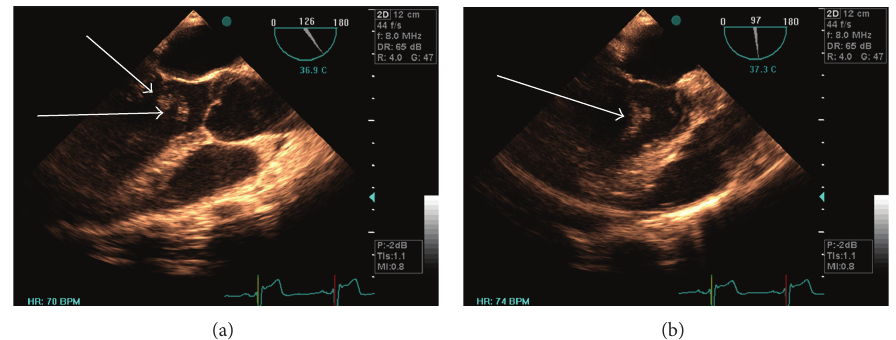
Figure 2: Transesophageal echocardiographic image showing mobile LV masses attached to the mitral valve and the posterior wall extending to LV outflow tract.